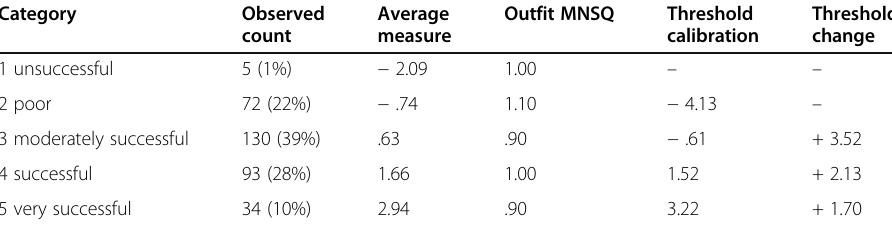
Table 6 Ratio of human rating